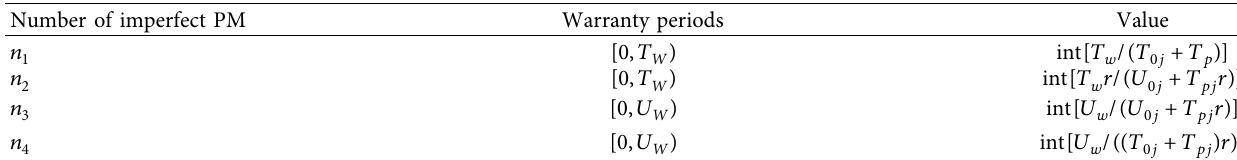
Table 1: Values of imperfect PM in different warranty periods.